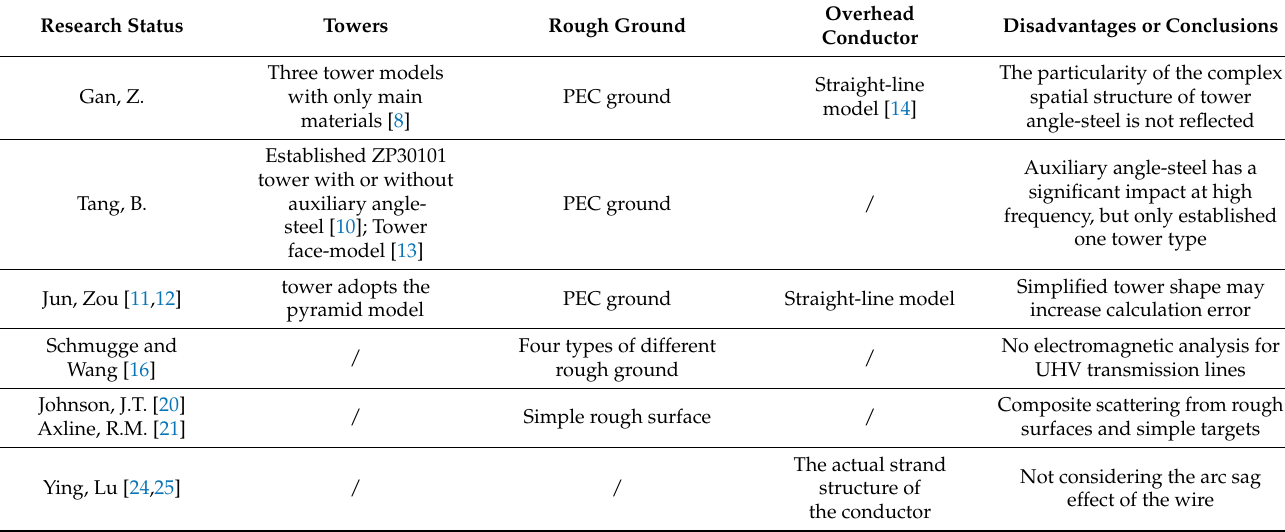
Table 1. Summary of current transmission line passive interference